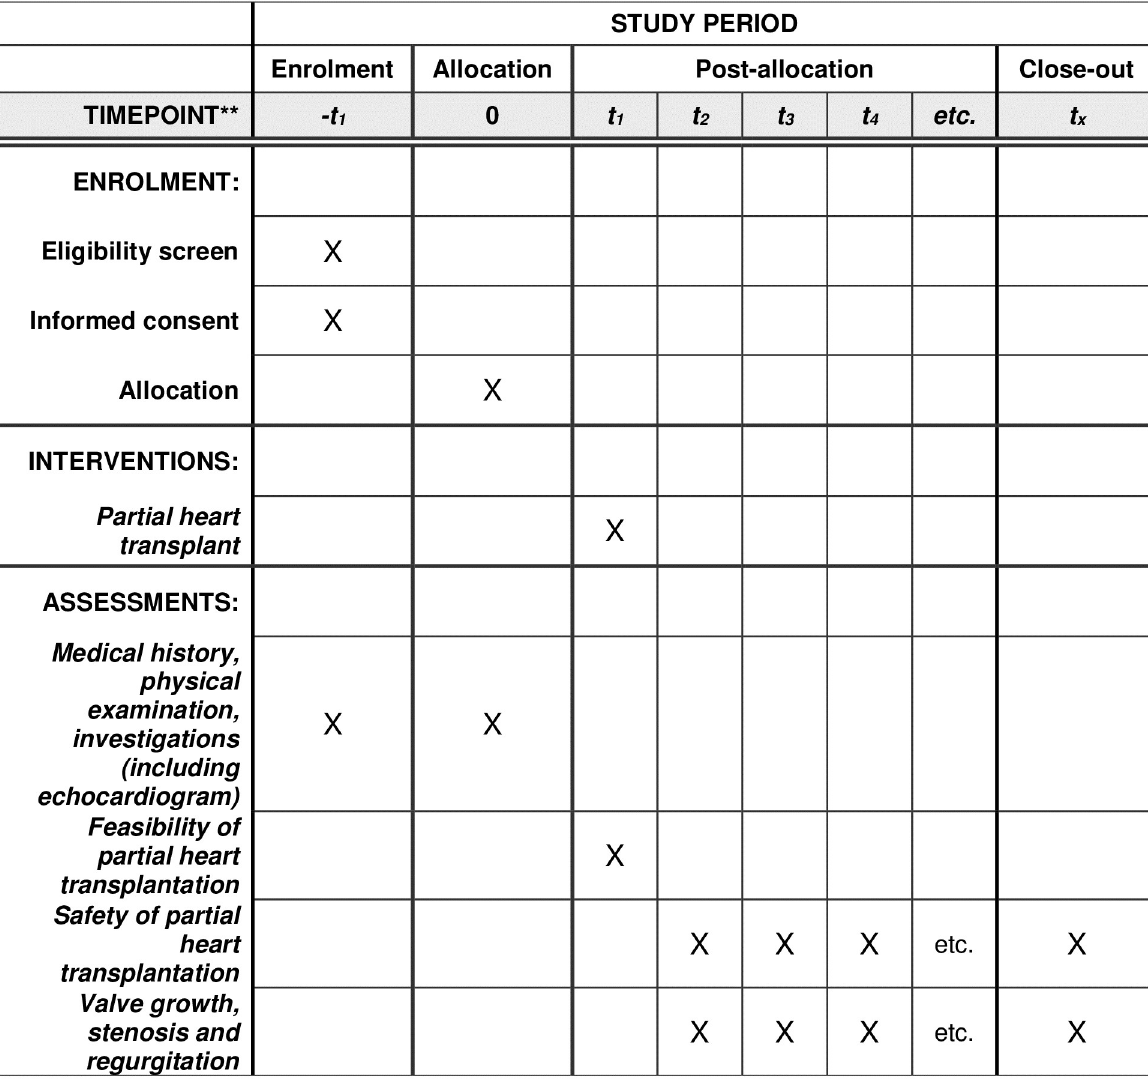
Fig 1. Schedule of enrolment, interventions, and assessments. The figure shows Standard Protocol Items: Recommendations for Interventional Trials (SPIRIT) schedule of enrolment, interventions and assessments information. �� Post-allocation time points occur at 6 months intervals, starting when the first subject undergoes partial heart transplantation and continuing until one year after all subjects have been enrolled.